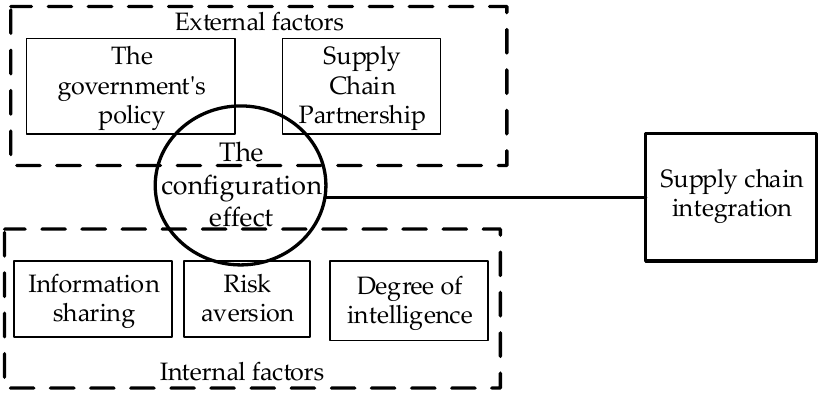
Figure 1. The research framework of supply chain integration theory.